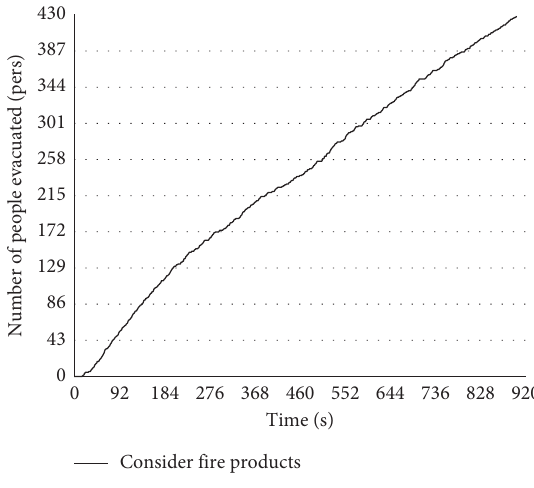
Figure 31: Exit 5 evacuation situation.